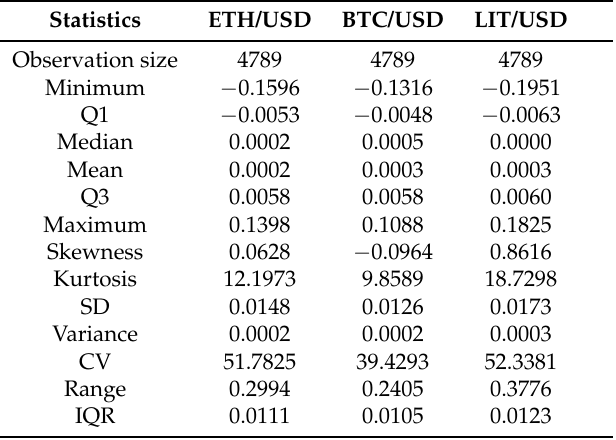
Table 1. Summary statistics of log returns of hourly market price index during a bull market in ETH/USD, BTC/USD and LTC/USD.